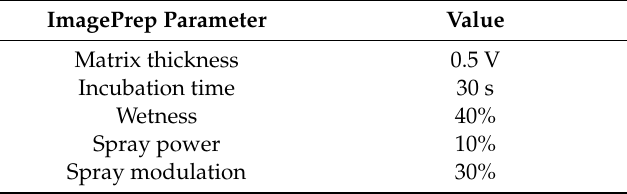
Table 1. ImagePrep parameters of the optimized matrix solution application